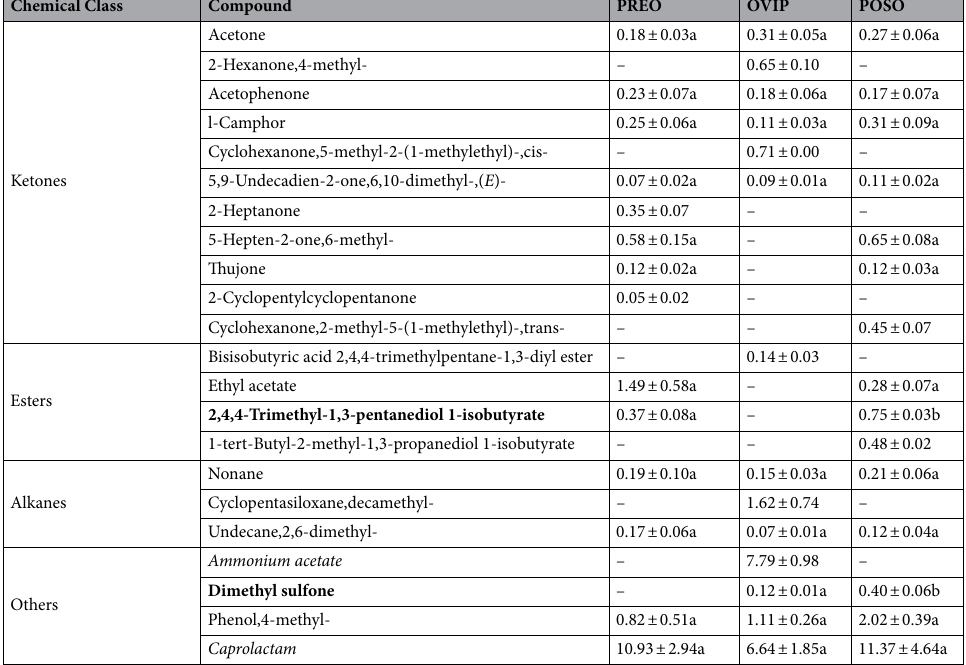
Semi-fresh and Dry, and 7 volatiles were common to all three feces with different freshness states. In addition, 14, 3 and 3, were common between Fresh and Semi-fresh, Semi-fresh and Dry, as well as Fresh and Dry, whereas 24, 17, and 15 were unique to Fresh, Semi-fresh, and Dry, respectively (Table 2; Fig. S2). Aromatic hydrocarbons and alkenes, acids and ketones, as well as alcohols and aldehydes were the two main chemical classes of Fresh, Semi-fresh, and Dry in respective. Except esters and ‘others’ which showed no significant difference in the feces, there were significant differences among other seven classes in at least one pairwise comparison of the three freshness states (One-way ANOVA, Independent t -test or Kruskal–Wallis test: P < 0.05) (Fig. 3). NMDS analysis revealed no overlap among the three states, and noticeably, three data points per states were all identical (Fig. 4). Moreover, ANOSIM indicated there were significant differences among the three states (R = 1, P = 0.005). Of the twelve volatiles which were one of the five most abundant volatiles at least in one state, only caprolac- tam occurred in all three states, which was not significantly different among Fresh, Semi-fresh and Dry (One- way ANOVA: F = 4.876, df = 2, P > 0.05). Besides, butanoic acid was common to Semi-fresh and Fresh, and its level in the former was higher than that in the latter (Independent t -test, t = - 3.018 , df = 4 , P = 0.039) (Table 2). It is worthy to note that toluene, 1,6-octadiene,3,7-dimethyl-,( S )-, and ammonium acetate were unique to Fresh (i.e., OVIP), and acetophenone, acetic acid, and 1,5,9-undecatriene,2,6,10-trimethyl-,( Z )- were unique to Semi-fresh among the twelve volatiles mentioned above. Although not one of the five most abun- dant volatiles, another twenty-two volatiles were also unique to Fresh, of which cyclohexene,3-methyl-6-(1- methylethyl)-, butanoic acid,2-methyl-, 1,4-cyclohexadiene,1-methyl-4-(1-methylethyl)-, hexanoic acid, cyclopentasiloxane,decamethyl- and pentanal were higher than 1% in relative content. Similarly, another six- teen volatiles were also unique to Semi-fresh, of which propanoic acid,2-methyl-, 1-pentanol, 2-pentanone, 2-butanone,3-hydroxy-, 2-hexanone, 2-hexanone,5-methyl-, 2-heptanone,5-methyl-, 2-octanone and ethanol,2- nitro-,propionate (ester) were higher than 1% (Table 2). Among the 27 volatiles common to two or three states, except for butanoic acid and acetophenone which belonged to the five most abundant volatiles, only twelve volatiles were significantly different in relative content in at least one pairwise comparison of the three states. Of which, 1H-indene,1-methylene- was higher in Dry than in Fresh (Independent t -test, t = − 9.288 , df = 4 , P = 0.001), limonene was higher in Dry than in Semi-fresh (Inde- pendent t -test, t = − 3.747 , df = 4, P = 0.020), so was 3,4-Dihydroxybenzyl alcohol,tris(trimethylsilyl)- (Independ- ent t -test, t = − 9.007 , df = 4 , P = 0.001). Nonanal and heptanal were higher in Dry than in Semi-fresh (One-way ANOVA: P < 0.001 and P = 0.002) or Fresh ( P < 0.001 and 0.001) with significant differences between Semi-fresh and Fresh ( P = 0.030 and 0.009). Decanal and octanal were higher in Dry than in Semi-fresh (One-way ANOVA: